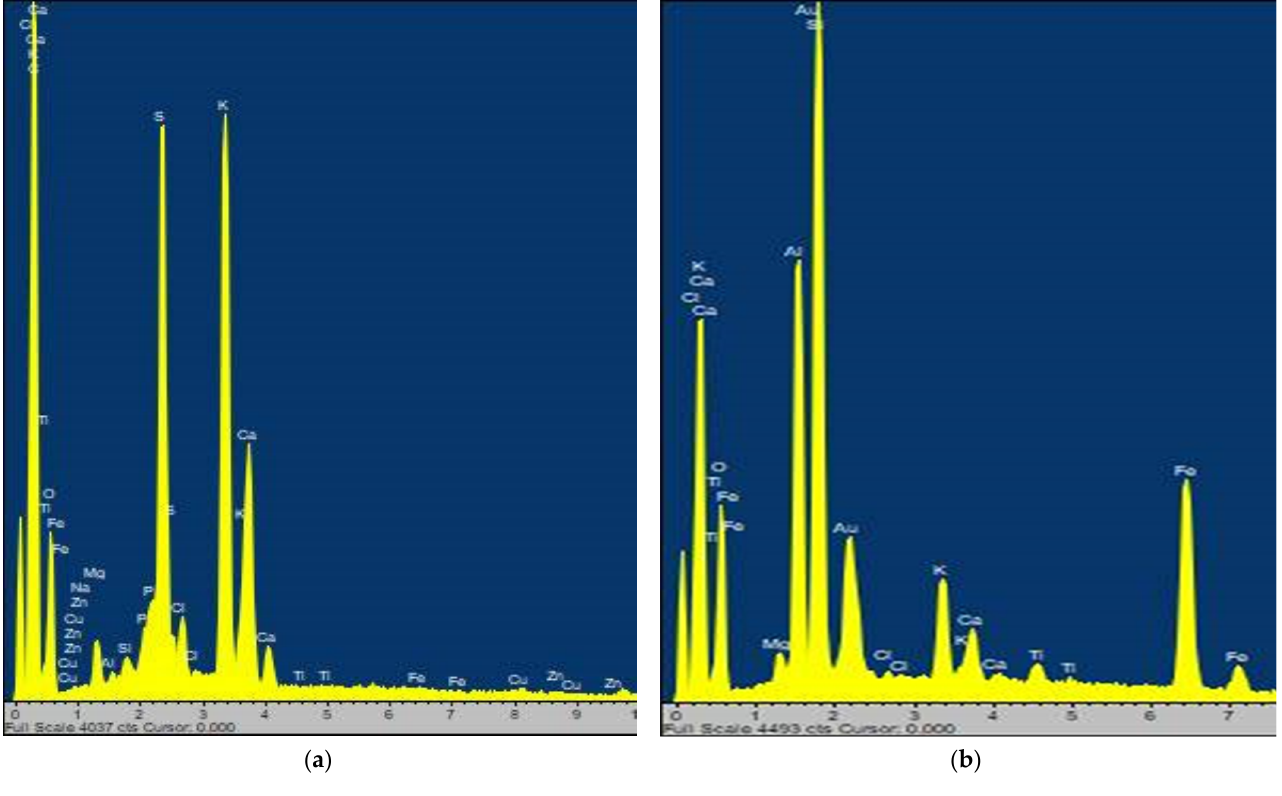
Figure 1. The SEM ‐ EDS spectra of ( a ) MOLP and ( b ) SDMOLP. Figure 1. The SEM-EDS spectra of ( a ) MOLP and ( b )